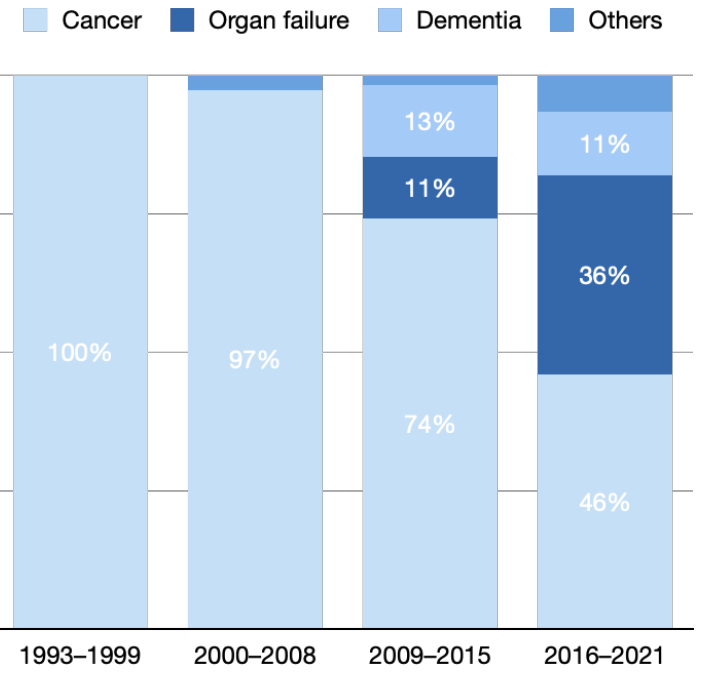
Figure 5. Distribution of studies with specific diseases of interest in different